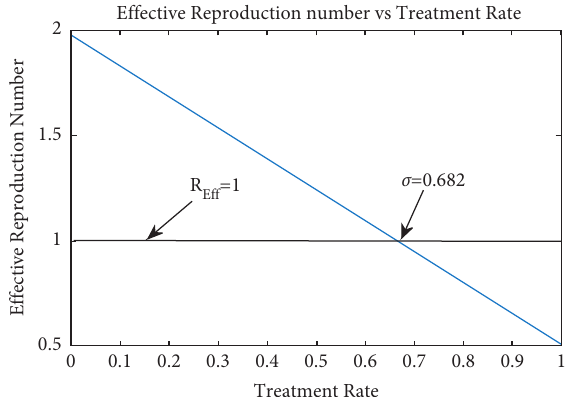
Figure 6: Behavior of effective reproduction number in relation to treatment rate, σ .